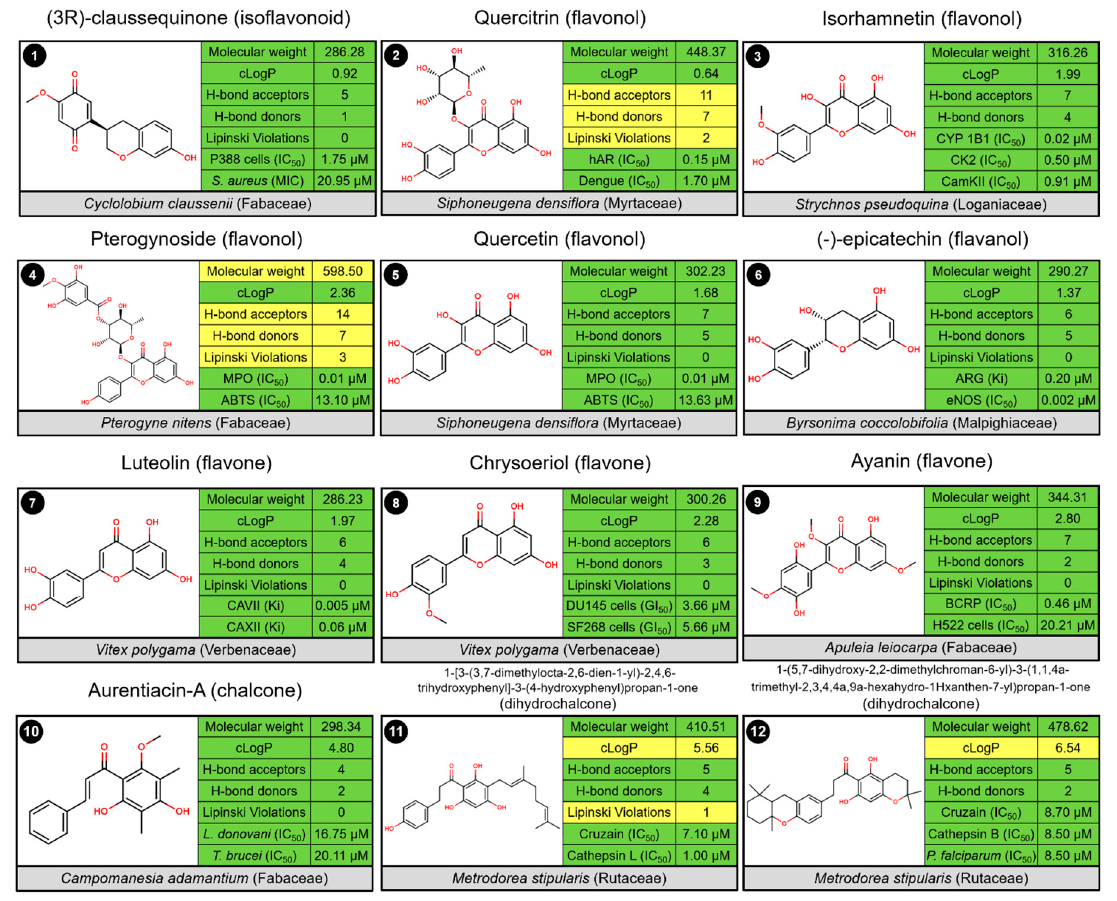
Figure 4. Examples of promising starting points for drug discovery.